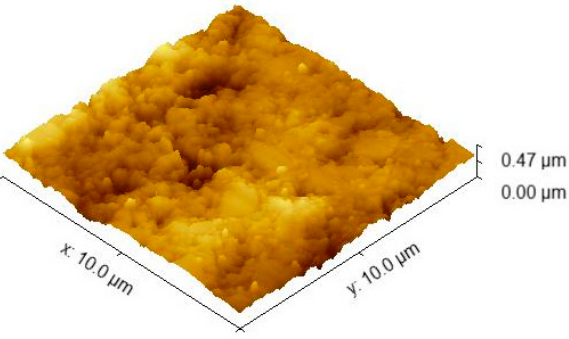
Figure 7. 10 × 10 µm 3D AFM image of the 3D-printed E-Dent 100 sample.